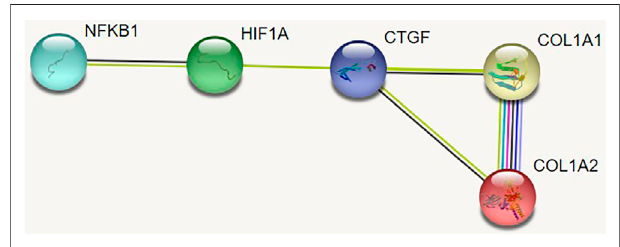
FIGURE 7 | PPI network was used to analyze interactions between NF- κ B, HIF-1 α , CTGF, and COL-1A.